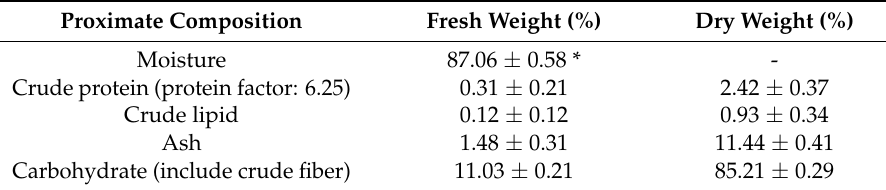
Table 1. Proximate composition of cacao pod